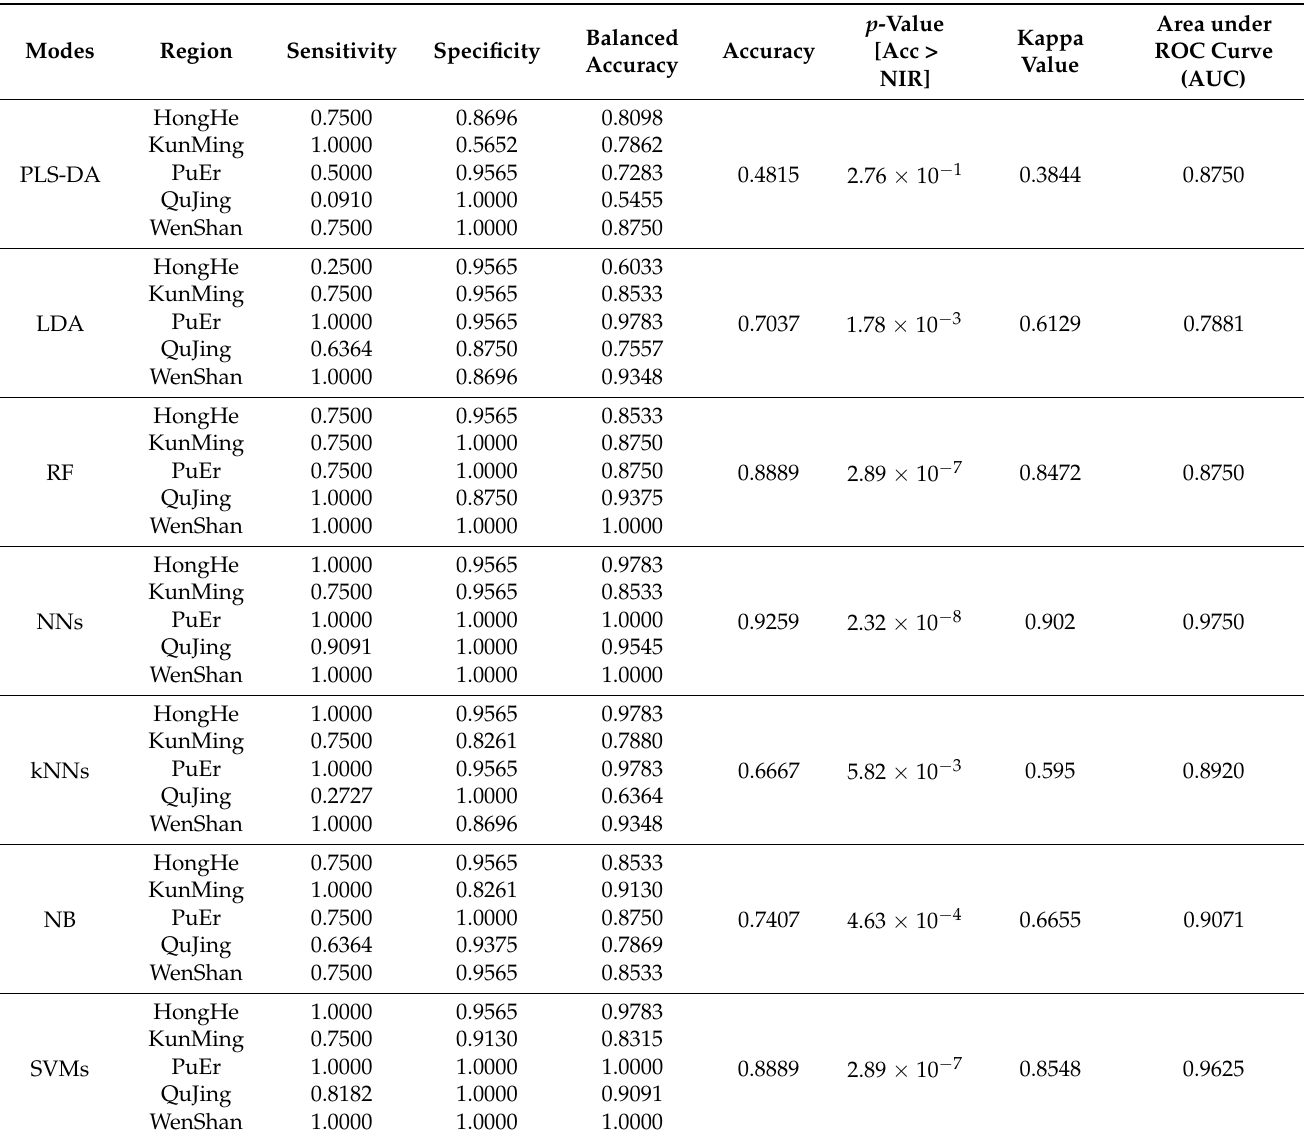
Table 1. The major parameters of models of each class based on the content of multi-element in P. notoginseng from different